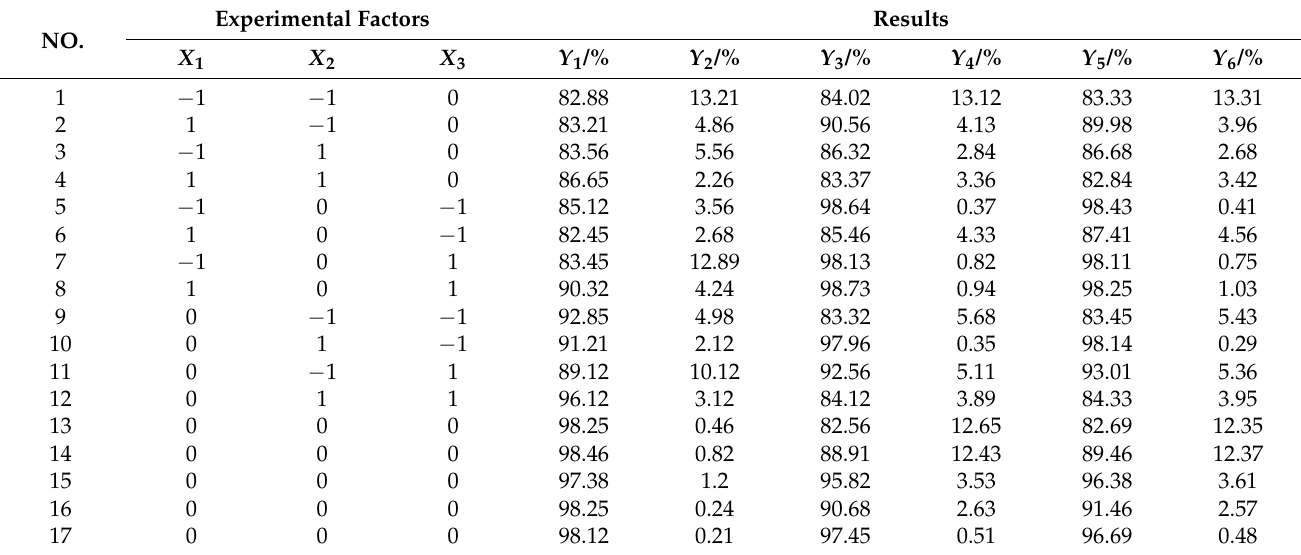
Table 3. Test results.